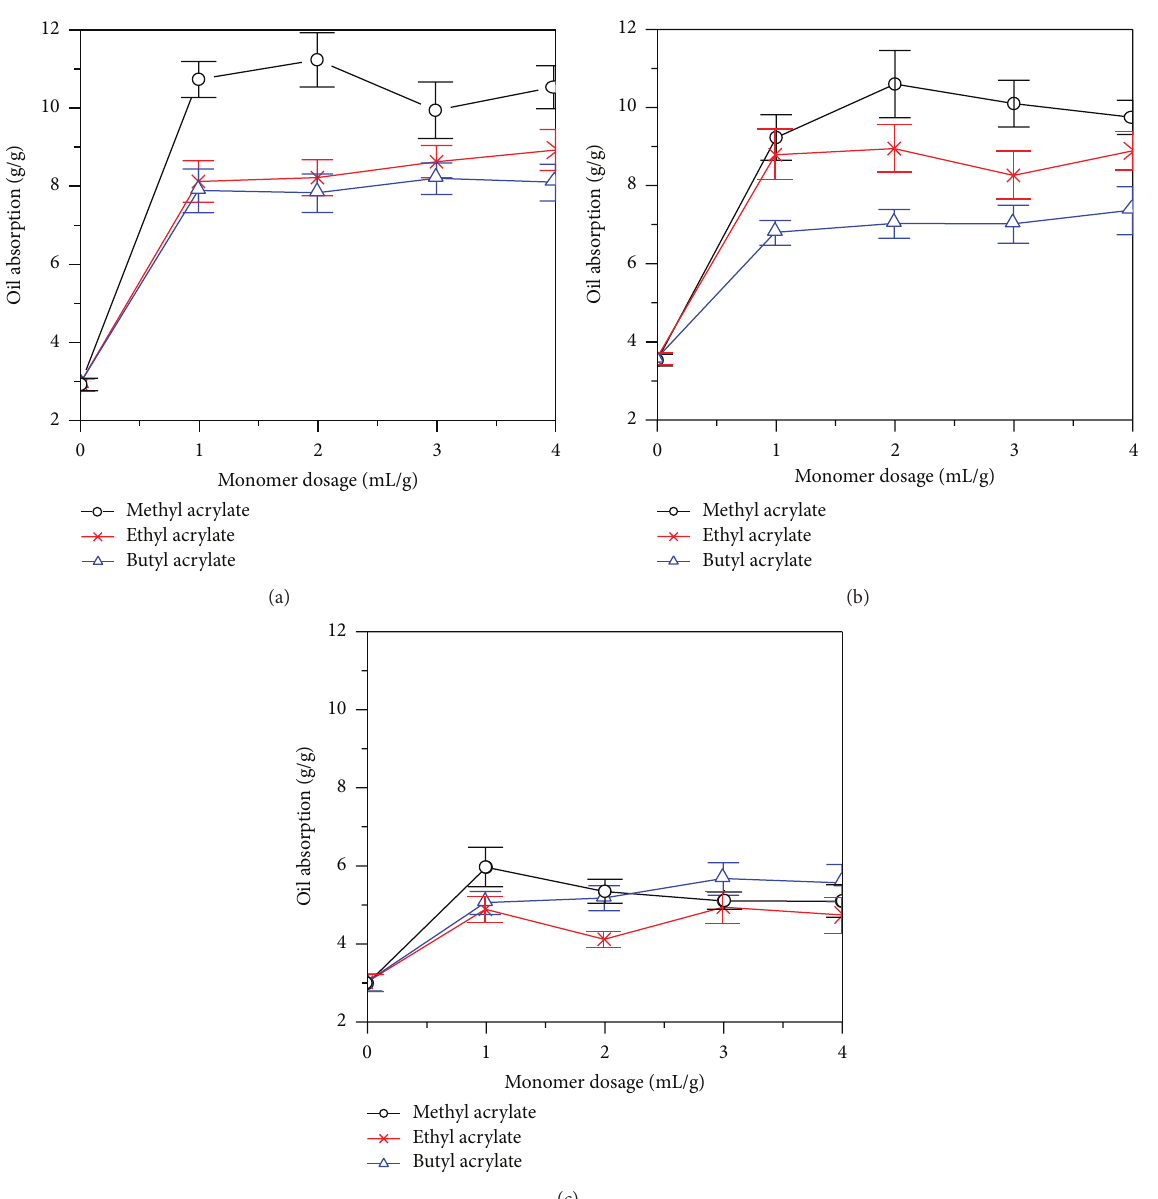
Figure 3: Oil absorption capacity of the sugarcane bagasse graft copolymers. (a) Machine oil absorption capacity; (b) cooking oil absorption capacity; (c) diesel oil absorption